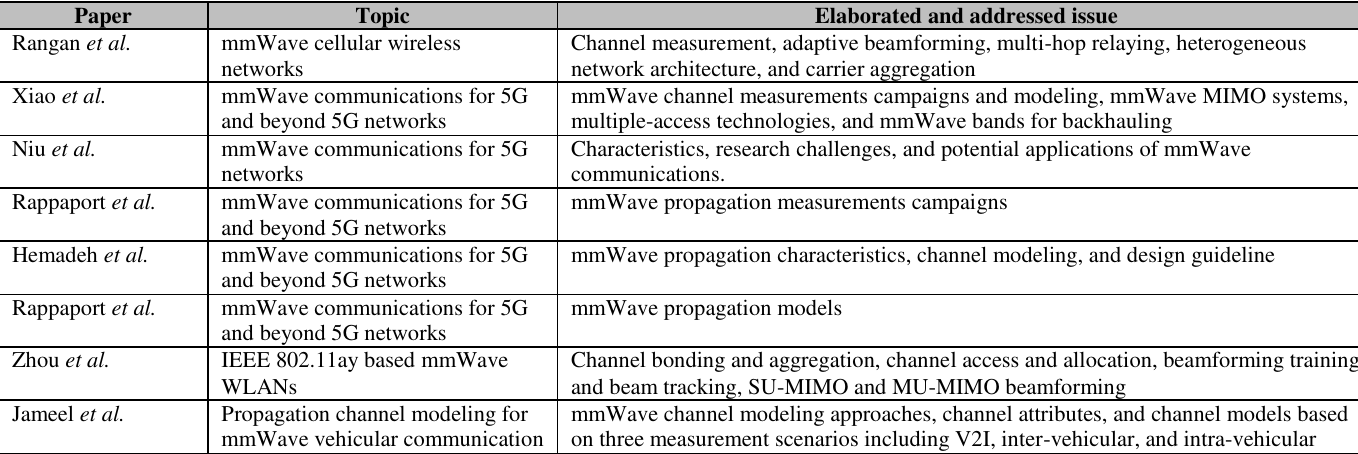
TABLE I: PAPERS RELEVANT TO 5G MMWAVE